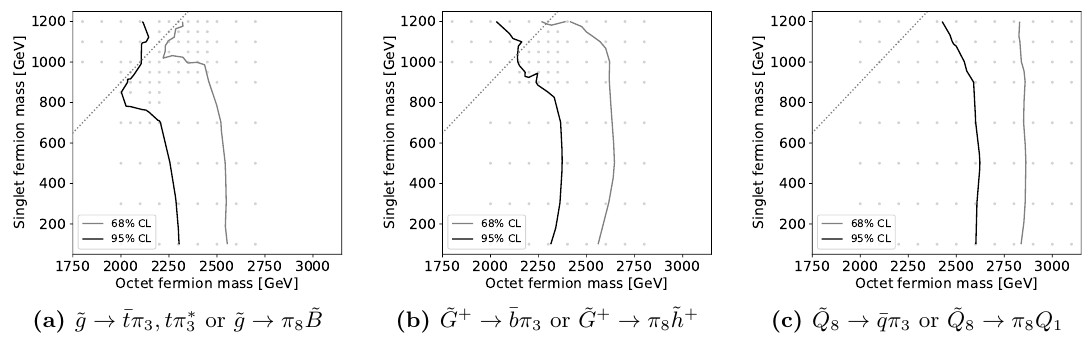
Figure 9. Bounds on the fermion masses for QCD pair production of color octet top partners Q 8 with subsequent decay via π and π with comparable branching ratios. The scalar masses are fixed 3 8 to m = 1 . 4 TeV ond m = 1 . 1 TeV. Above the dotted line, Br( Q π 3 π 8 ¯ t ) = 50% take Br( π ) = Br( π 8 → gg 8 → t